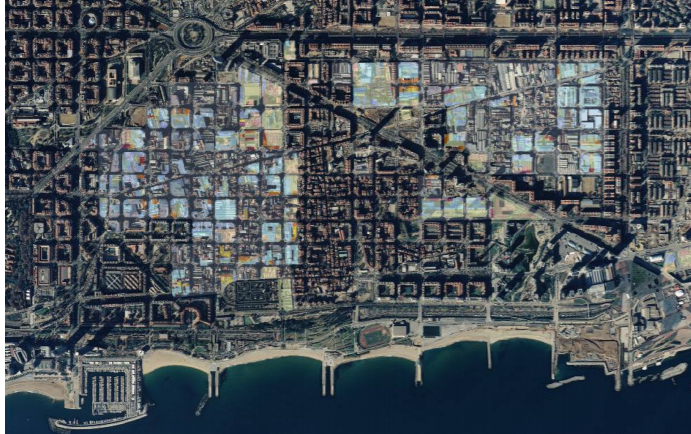
Figure 2 . Satellite image of the 22@ district (source: Municipality of Barcelona) . Figure 2. Satellite image of the 22@ district (source: Municipality of Barcelona). Urban Sci. 2020 , 4 , 16